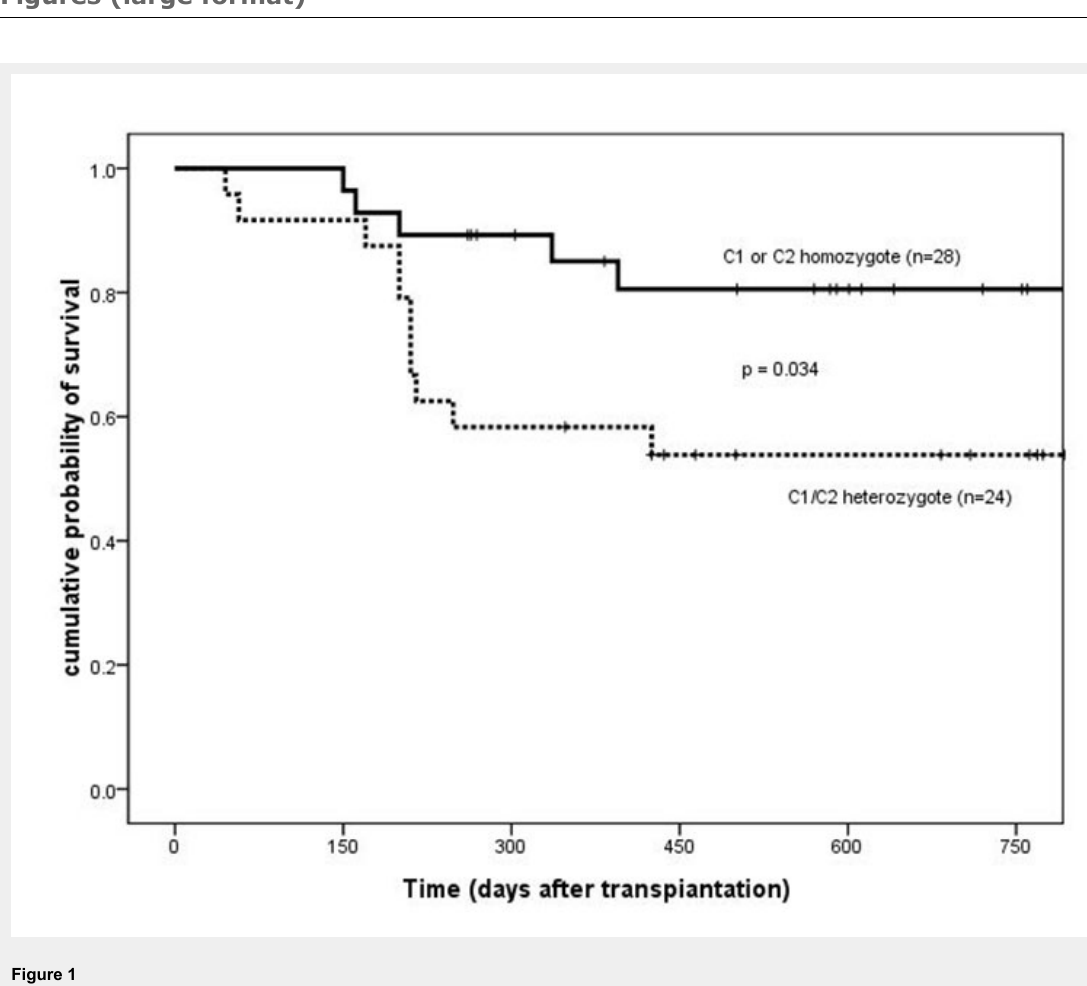
Figure 1 Overall survival of patients based on HLA-Cw ligand groups (C1 or C2 homozygote vs C1/C2 heterozygote). HLA = human leukocyte